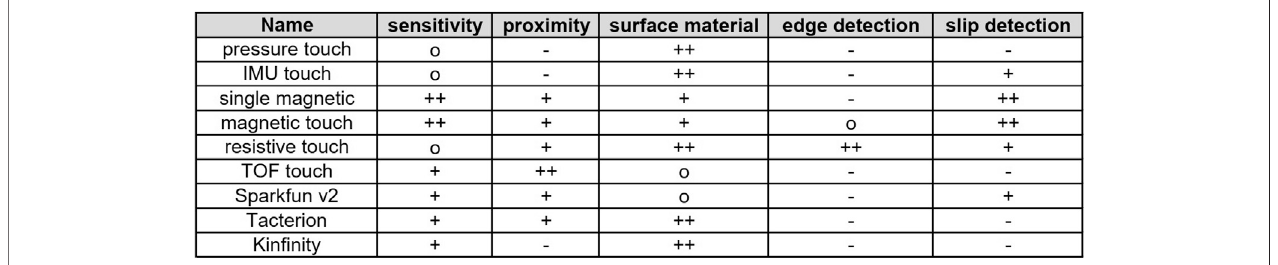
Frontiers in Robotics and AI |